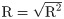
Network connectivity can be well estimated even with low observation ratios.With N = 50 neurons, and an experiment length of 5.5 hours, we examine various observation probabilities: p
obs = 1,0.2,0.1,0.04. Left
(A,B,F,J,N): weight matrix (either true or estimated). Middle left
(C,G,K,O): non-zero weights histogram (blue—true, red—estimated). Middle right
(D,H,L,P): inferred weight vs. true weight. Right
(E,I,M,Q): quality of estimation—S = sign detection, Z = zero detection, C = correlation, R=R2 (for exact definitions see Eqs 40–43 in S1 Text); higher values correspond to better estimates. In the first row, we have the true weight matrix W. In the other rows we have the inferred W—the MAP estimate of the weight matrix with the L1 prior (section C in S1 Text), with λ chosen so that the sparsity of the inferred W matches that of W. Estimation is possible even with very low observation ratios; in the lowest row we observe only 2 neurons out of 50 in each time bin. The weights on the diagonal are estimated better because we observe them more often in double serial scanning scheme (Fig 1I, 1J).